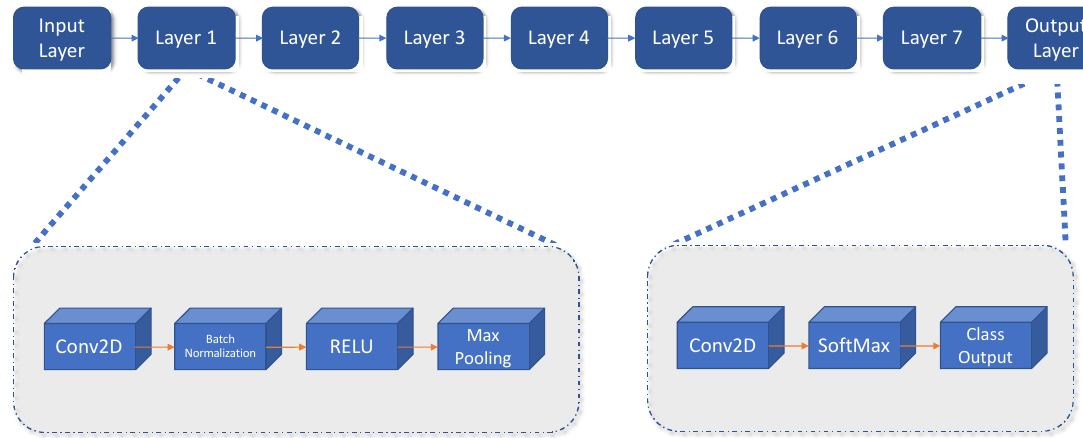
Figure 5. Schema of the Darknet network model. Table 3. Detail of the convolutional layers in the Darknet CNN.